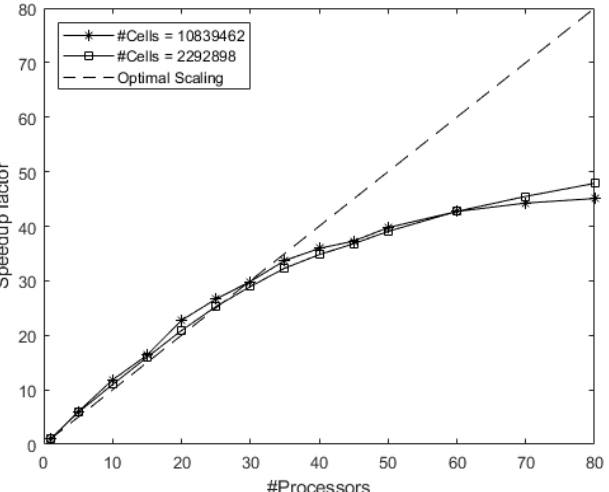
Figure 3. Parallel scaling using two different mesh sizes of the RANS solver on the real geometry of the Parade Square in Warsaw,